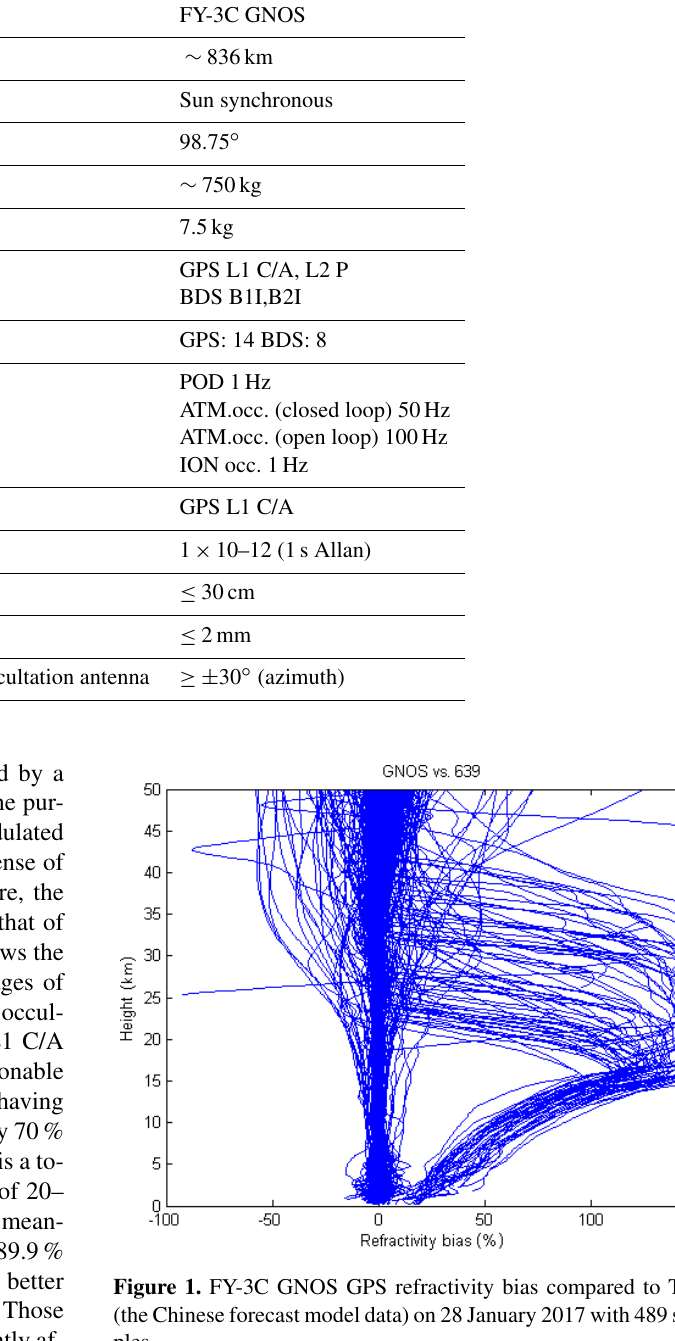
Table 1. The main instrumental parameters for FY-3C GNOS.